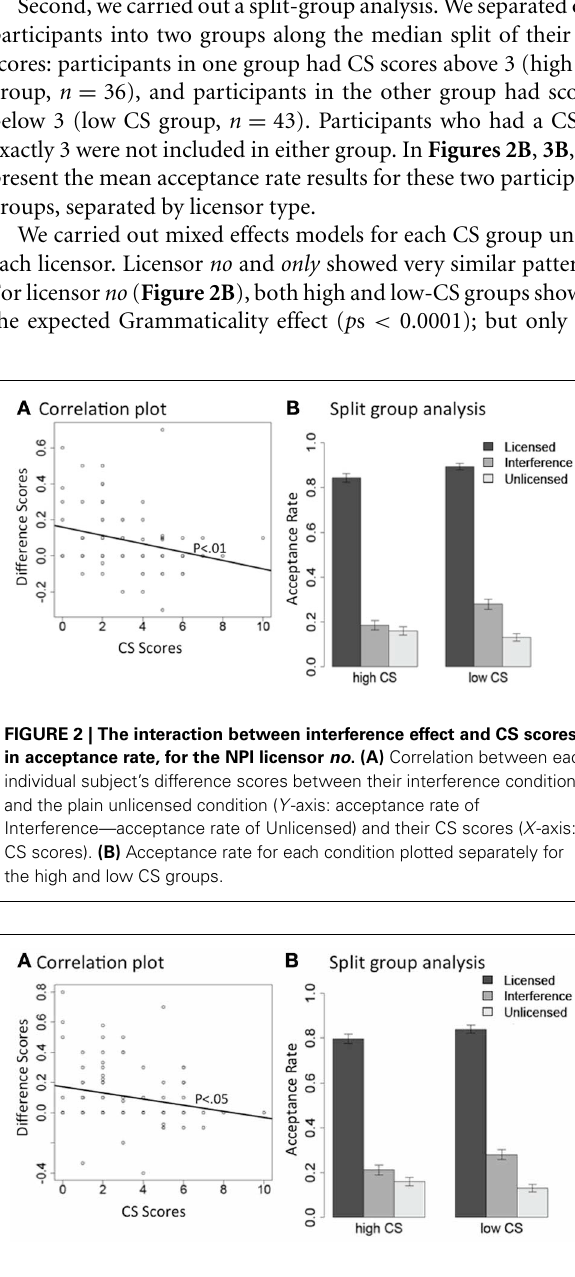
FIGURE 3 | The interaction between interference effect and CS scores in acceptance rate, for the NPI licensor only . (A) Correlation between each individual subject’s difference scores between their interference condition and the plain unlicensed condition ( Y -axis: acceptance rate of Interference—acceptance rate of Unlicensed) and their CS scores ( X -axis: CS scores). (B) Acceptance rate for each condition plotted separately for FIGURE 4 | Word-by-word reading times for the NPI stimuli set,